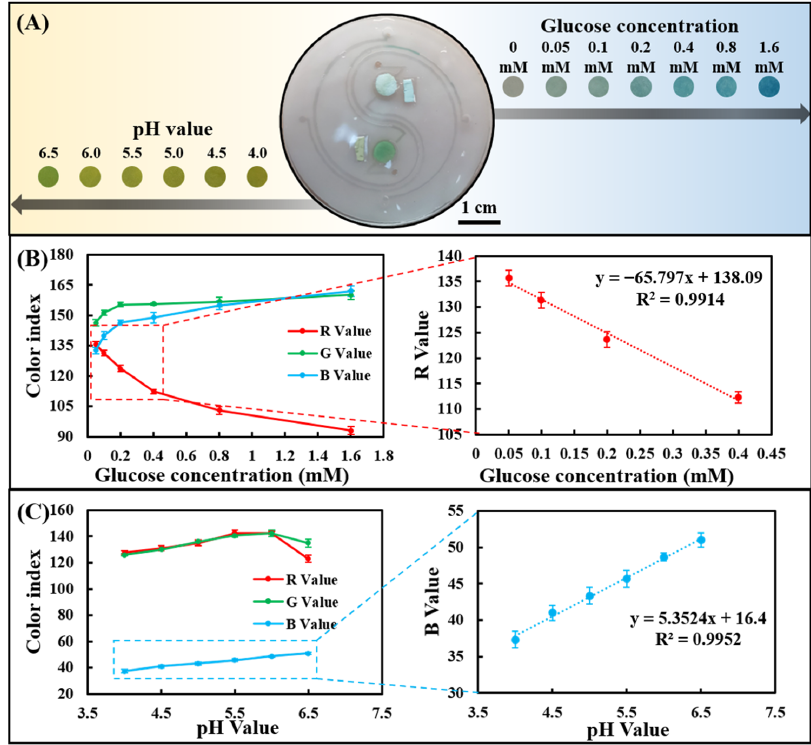
Figure 4. Determine the sweat glucose concentration and the pH value detection range in the chip using artificial sweat samples. ( A ) Optical images of the chip after reacting with artificial sweat samples. ( B ) RGB color index of the chip-based glucose assay and linear calibration curve for glucose in terms of the R-value. ( C ) RGB color index of the chip-based pH assay and linear calibration curve for pH in terms of the B value.